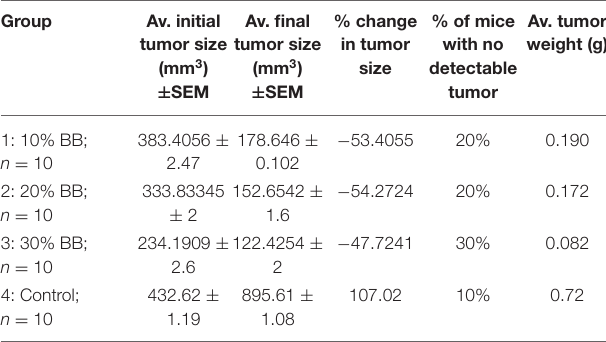
TABLE 9 | The effect of barley bran on tumor size and weight in mice ( n = 10) (mm 3 : cubic millimeter).